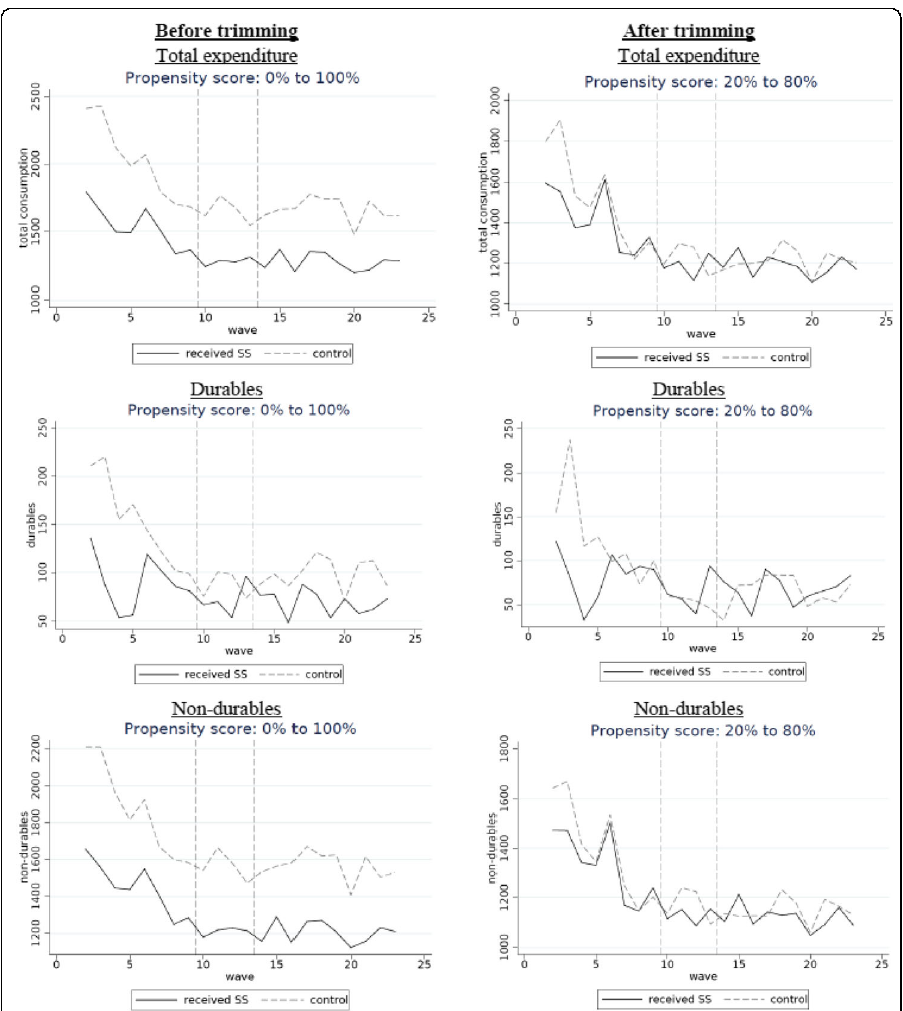
Fig. 4 Trends of key expenditure-related variables (The periods to the left of the first and second dotted vertical lines refer to the pre-announcement and pre-disbursement periods